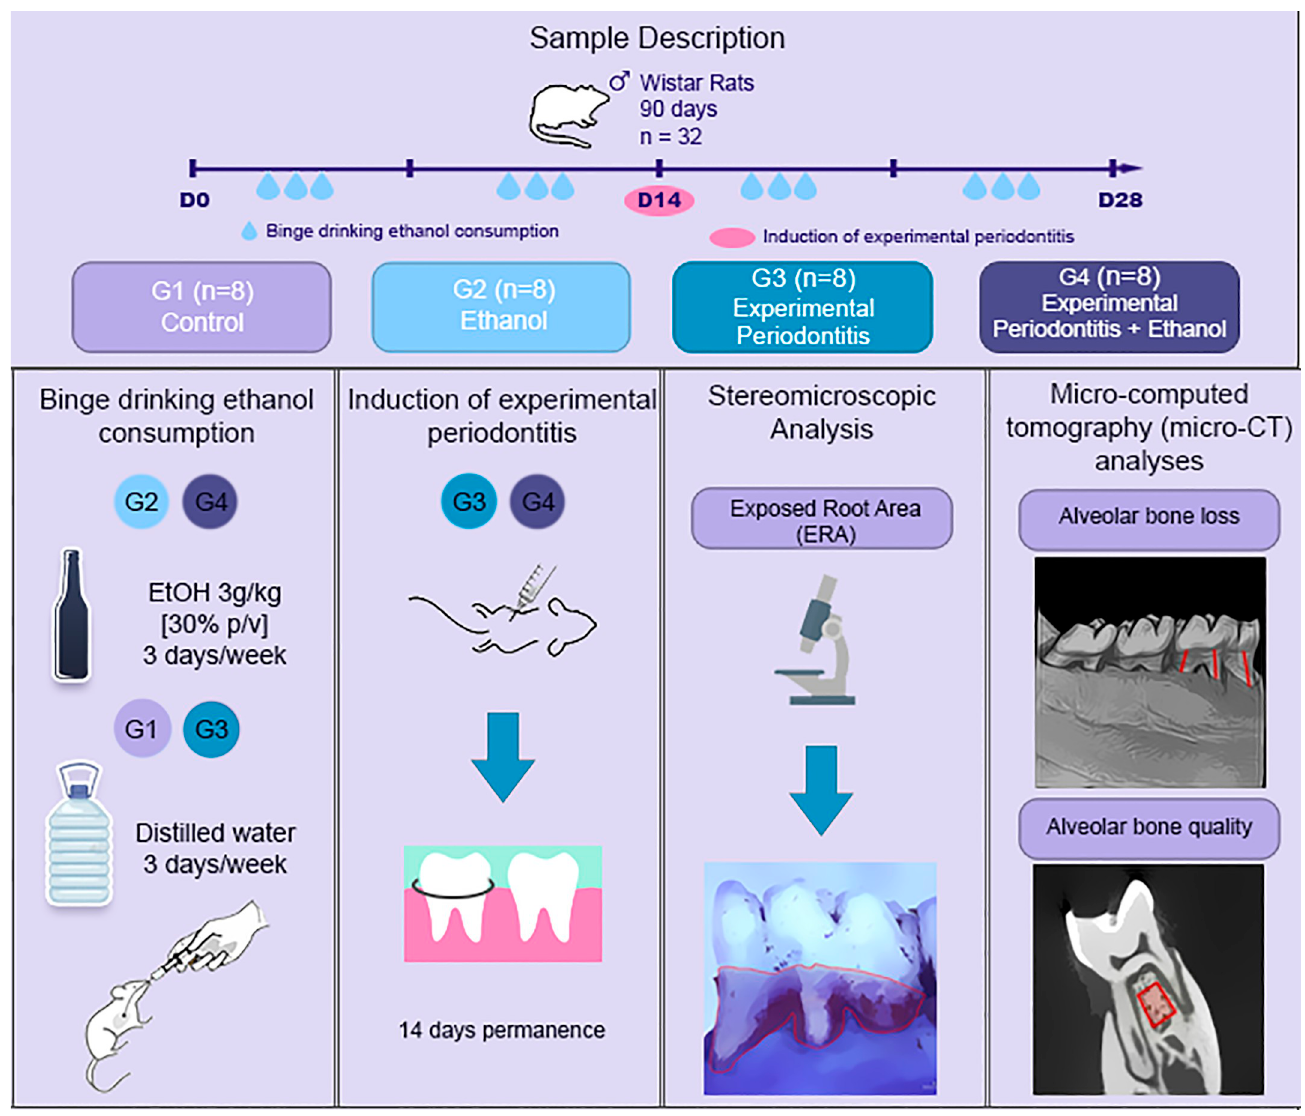
Fig 1. Sample description and experimental